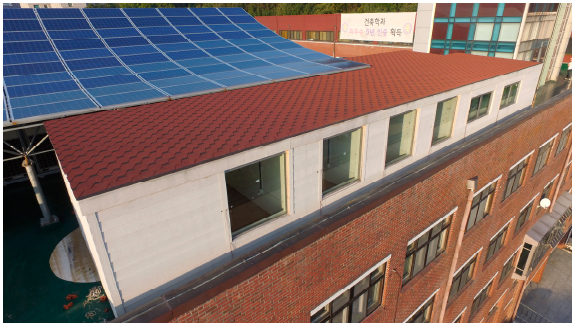
Figure 2 . Front view of mock-up test cells.